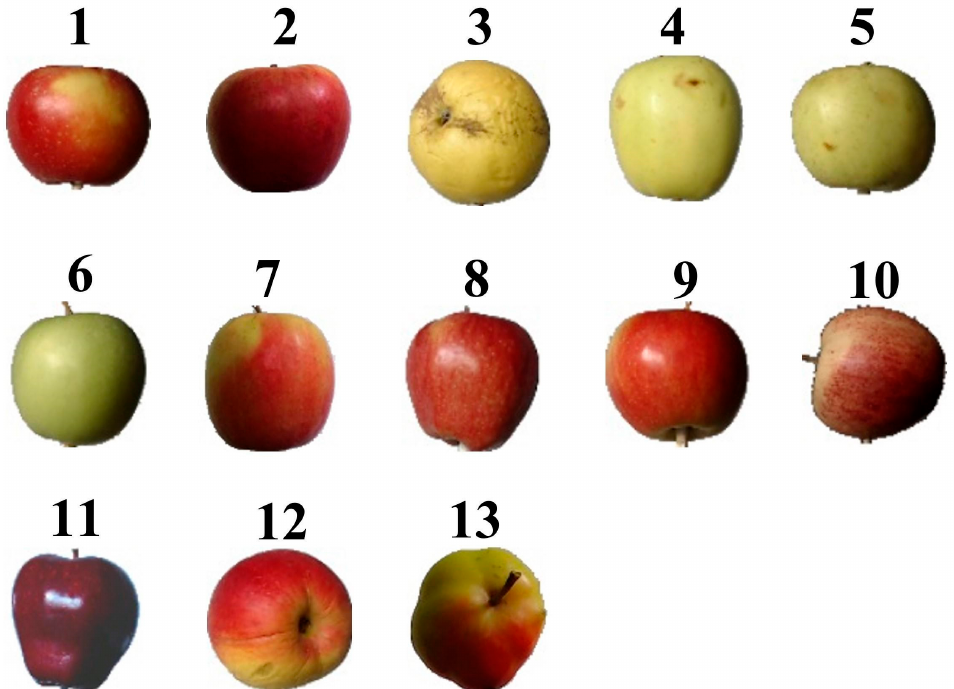
Figure 1. Thirteen classes of apples: 1. Braeburn, 2. Crimson Snow, 3. Golden 1, 4. Golden 2, 5. Golden 3, 6. Granny Smith, 7. Pink Lady, 8. Red 1, 9. Red 2, 10. Red 3, 11. Red Delicious, 12. Red Yellow 1, and 13. Red Yellow 2.